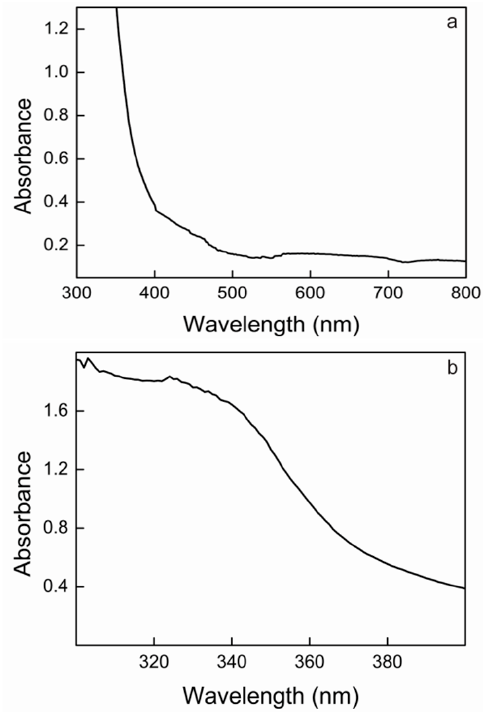
Figure 4. UV–Vis spectrum of pure Lacps1 ( a ), and detail of the range from 300–400 nm ( b ). The experiment was repeated three-fold with three separate preparations of pure Lacps1; representative spectra are presented.